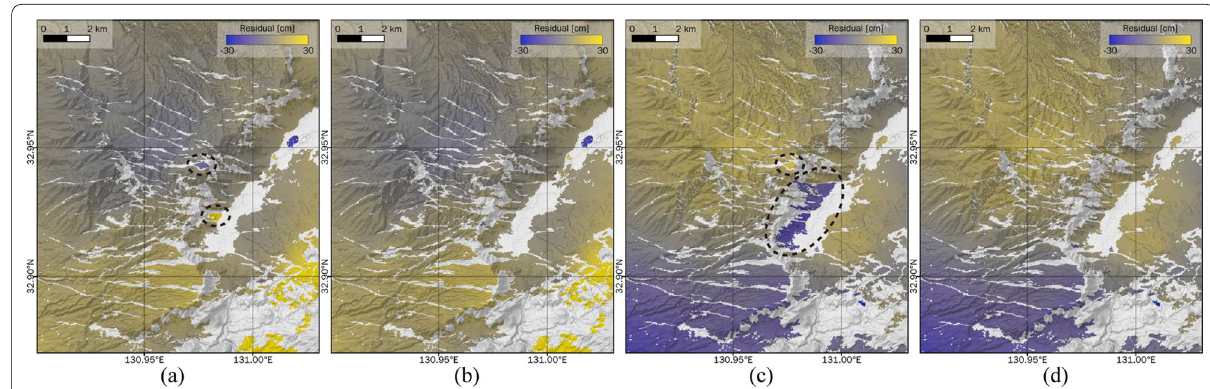
Fig. 8 Residuals between unwrapped phases with similar LOS directions. a Observed from the west (i.e., descending left-looking and ascending right-looking) before unwrapping error corrections. Ellipses with black dashed lines denote isolated components containing unwrapping errors. b Observed from the west after corrections. c Observed from the east (i.e., ascending left-looking and descending right-looking) before corrections. Ellipses with black dashed lines denote isolated components containing unwrapping errors. d Observed from the east after